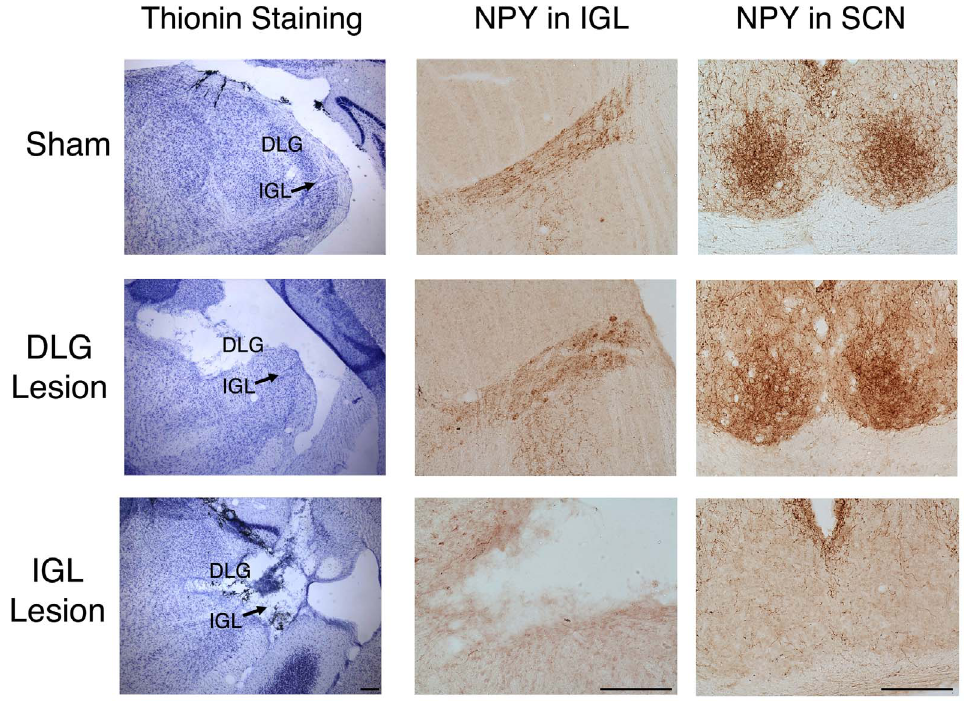
Figure 1. Histology from representative lesioned and sham-operated grass rats. Thionin stained sections through the lateral geniculate (left column) and NPY-labeled sections through the IGL (middle column) and the SCN (right column) from a representative sham (top row), a grass rat with a lesion that missed the IGL but destroyed the DLG (middle row), and from a grass rat with complete IGL lesions (bottom row). NPY was present in the IGL and SCN of shams and grass rats with DLG lesions, whereas NPY was absent in the IGL of grass rats with complete IGL lesions (bottom row). Scale bar represents 400 m m. Abbreviations: DLG: dorsolateral geniculate nucleus; IGL: intergeniculate leaflet; SCN: suprachiasmatic nucleus; NPY: Neuropeptide Y.